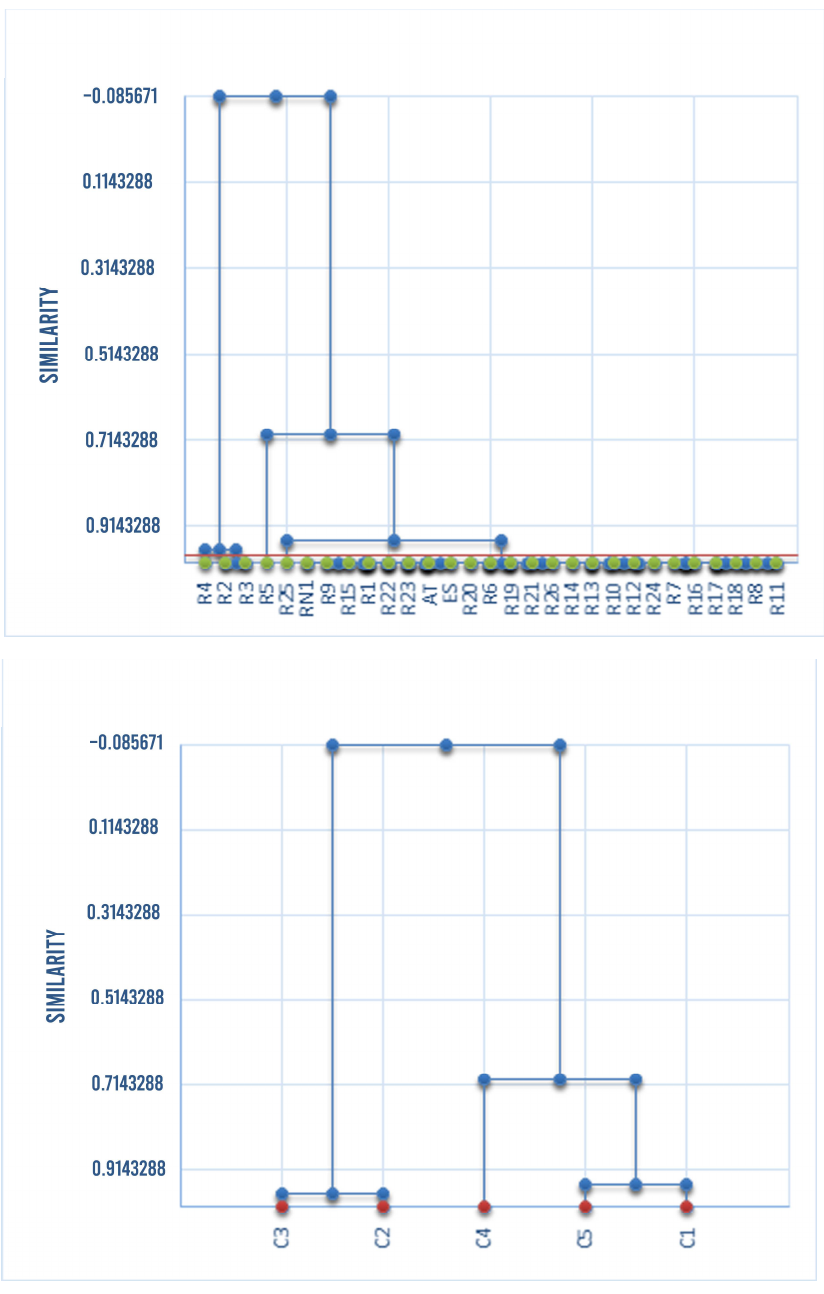
Figure 13. AHC Dendrogram of the min cluster analysis. From the AHC classification, indidivuals are grouped according to their similarities in order to represent them in the form of a classification tree so-called dendrogram (Figure 13). This discrimination brings out five classes, namely: class number 1 integrates the largest number of roads (24 roads) “RN1, AT, ES, R1, R6–R26” and has the highest intra-class variance (169,527,511,587,628) as shown in Table 2; class number 2 integrates only the two roads R2 and R3. Finally, the other three classes integrate only one road per class. In addition, the majority or the most important information is centered in class number 1 with respect to the factors studied as shown in Table